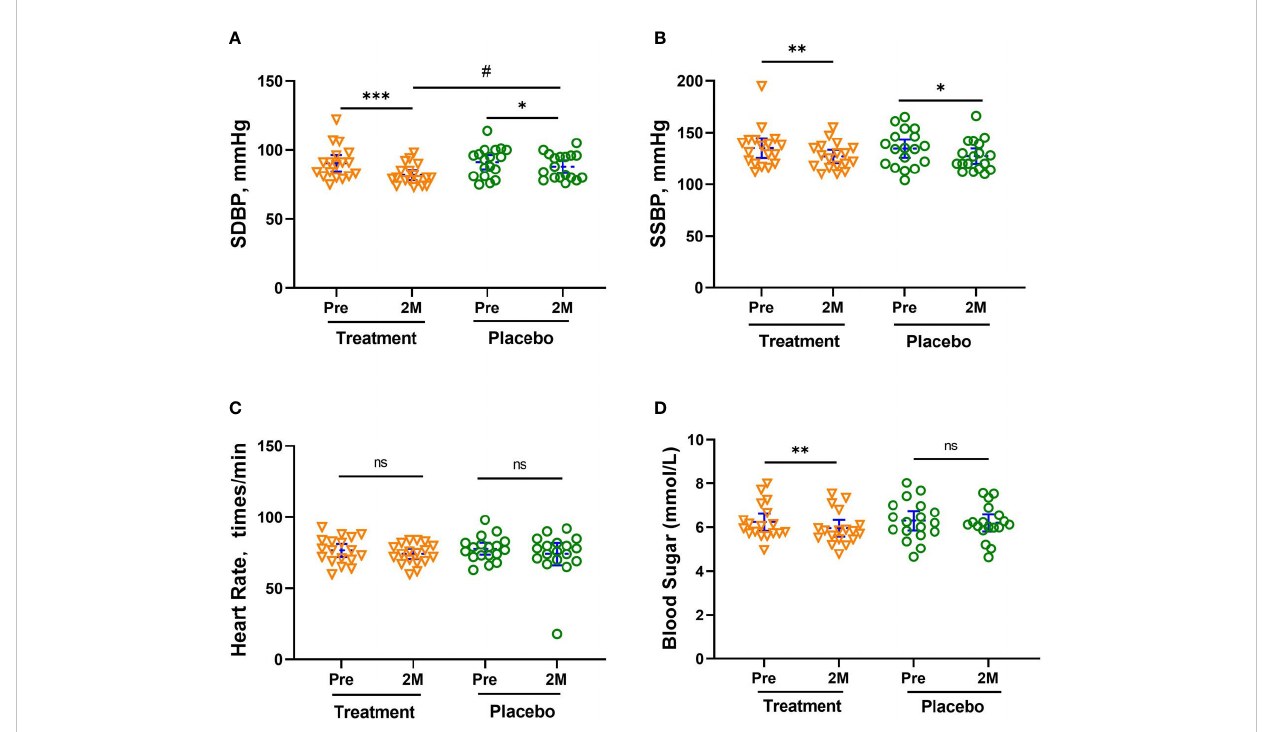
FIGURE 2 Mean Changes in SDBP (A) , SSBP (B) , HR (C) and Blood sugar levels (D) . The reduction in SDBP was signi fi cantly greater in the treatment group than in the placebo group after 2 months (2M). Bars (blue) were shown as mean of each group with 95% CI. All intra-group analyses were performed using one-way ANOVA followed by Bonferroni post hoc , and inter-group was performed by using t test followed by Mann-Whitney by Prism 9 software, (*, ** and *** represent p < 0.05, p < 0.01 and p < 0.001; # represents p < 0.05, ns represents no signi fi cant difference). Seated systolic blood pressure, SSBP, seated diastolic blood pressure, SDBP,